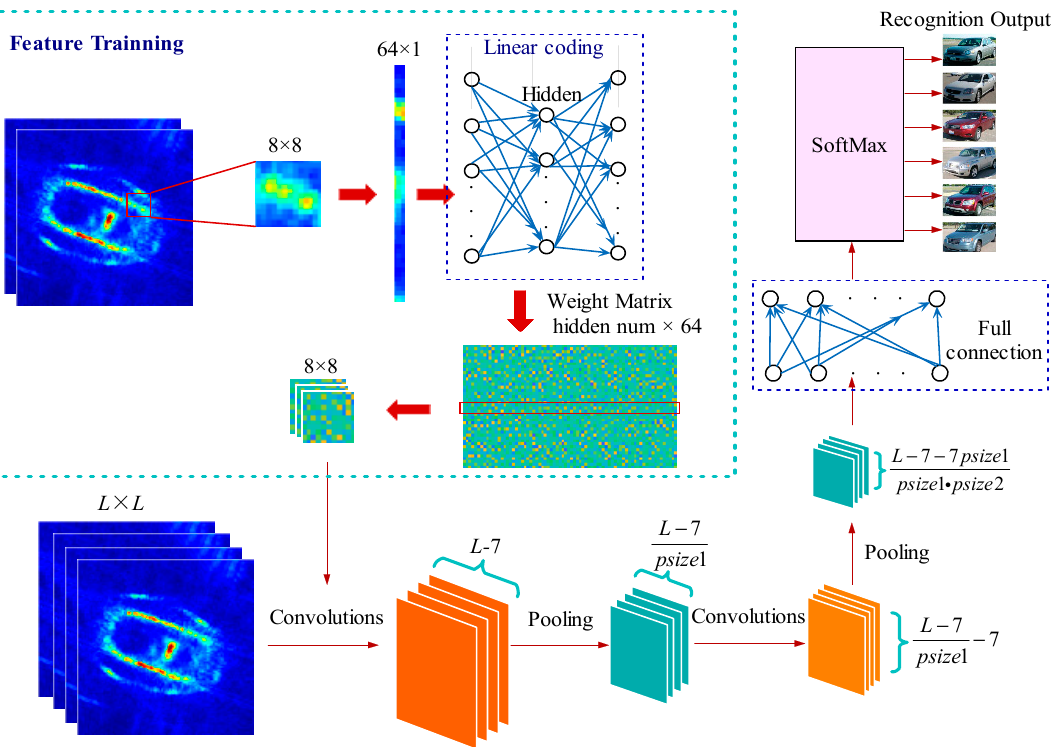
Figure 4. The architecture of convolutional neural networks (CNN) used in this paper. The input data is the residual compensation image of the vehicle target. The output of the network is the classification of vehicle targets. The network mainly includes feature training, convolution, pooling, and softmax regression.